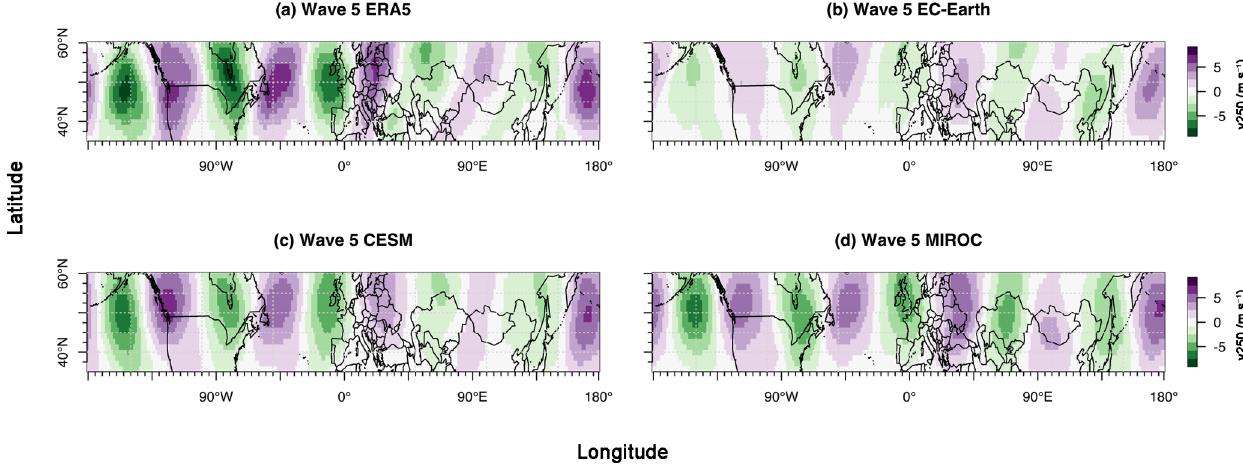
Figure B10. Composite anomaly plots of weeks with high-amplitude wave-5 episodes for meridional wind velocity at 250hPa (v250, anomaly) in ERA5 (a) , EC-Earth (b) , CESM (c) , and MIROC (d) based on the AISI control runs.